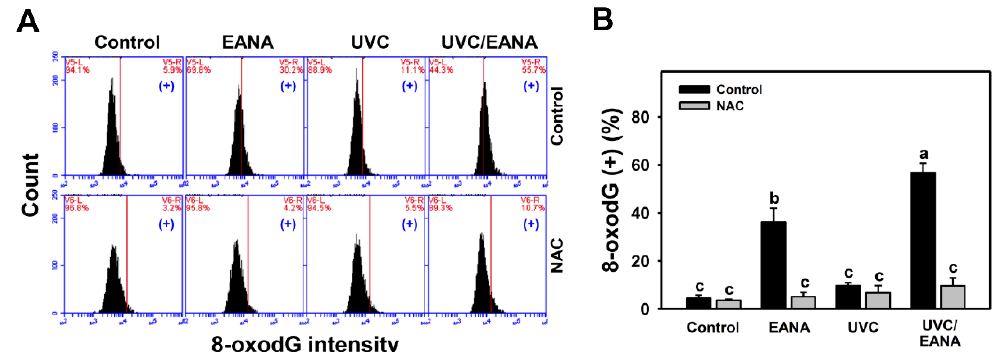
Figure 9. 8-oxodG analyses of EANA and / or UV treatments for human oral cancer Ca9-22 cells. With or without NAC (10 mM) pretreatment for 1 h, cells were post-treated with control (DMSO only), EANA (5 µ g / mL), UVC (12 J / m 2 ), and combined treatment (UVC / EANA) for 24 h. ( A ) Typical flow cytometry patterns for 8-oxodG content. 8-oxodG intensity-positive regions were marked as ( + ). ( B ) Statistical analysis for (A). Treatments showing no overlapping labels (a–c) di ff er significantly between multiple comparisons ( p < 0.0001). Data, mean ± SD ( n =